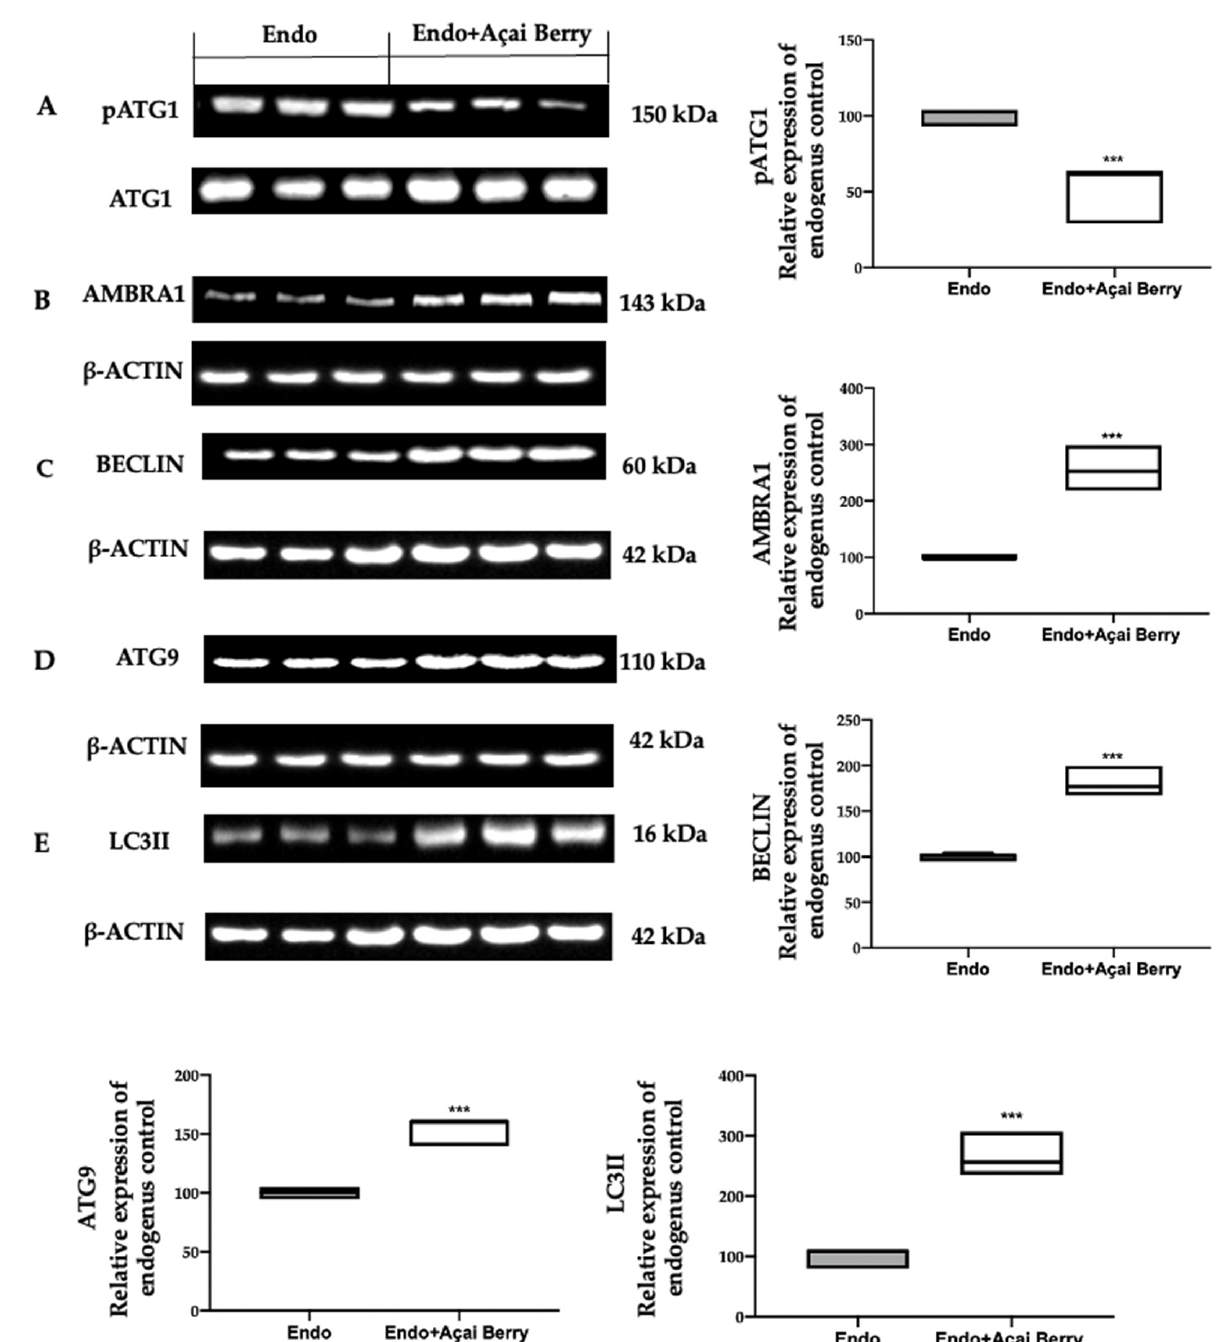
Figure 4. Analysis of Açai Berry administration on the autophagosome formation. Western blot analysis of pATG1 ( A ), AMBRA1 ( B ), BECLIN ( C ), ATG9 ( D ) and LC3II ( E ) expression. A p -value of less than 0.05 was considered significant. *** p < 0.001 vs. Endo.